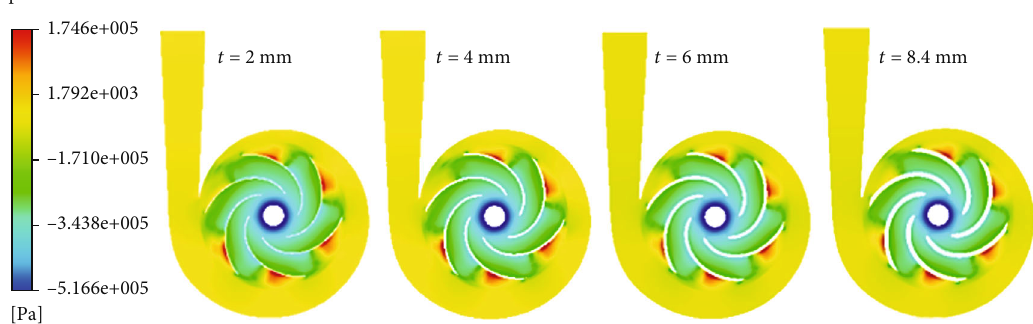
Figure 9: Pressure counters in the PAT impeller ’ s center